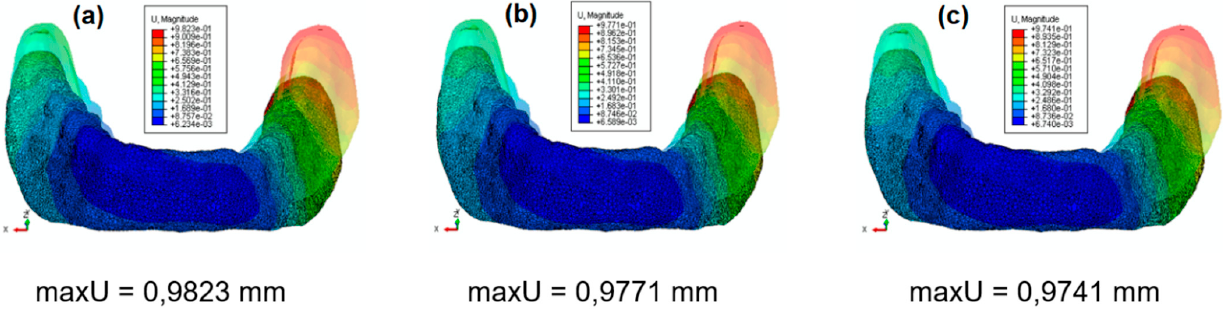
Figure 11. Comparison of the prosthesis movements during canine bite and application of three types of matrices: ( a ) POM-1, ( b ) POM-2, and ( c ) POM-3.